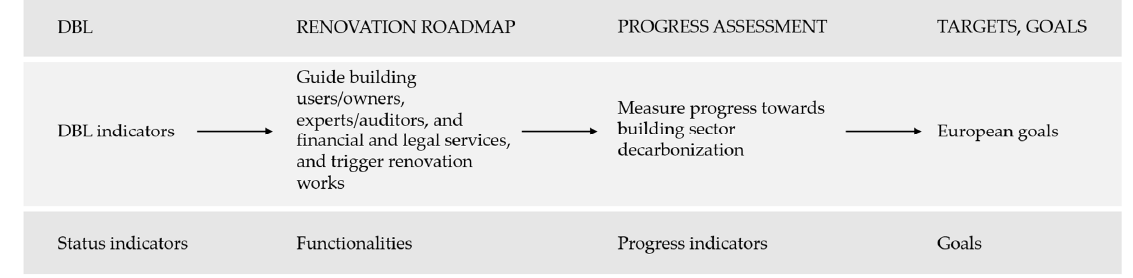
Figure 2. Future research scheme.